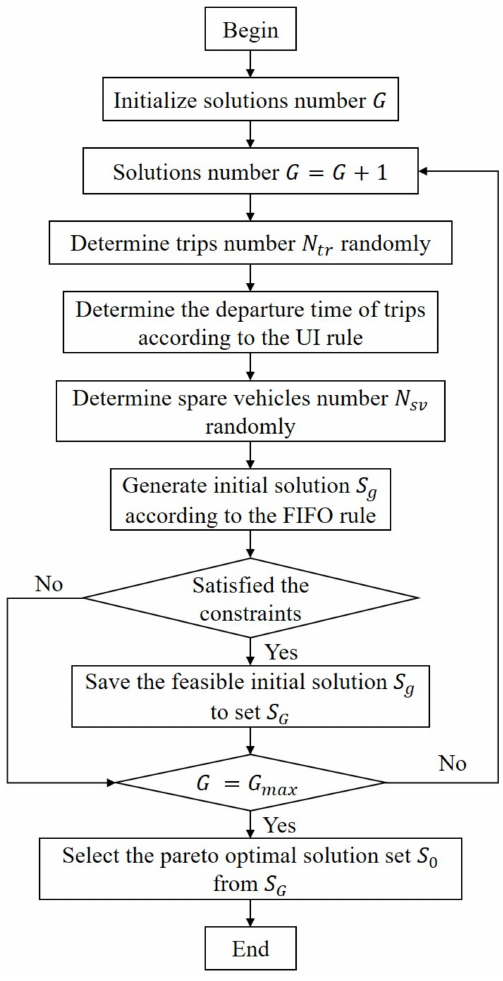
Figure 6. The flowchart of algorithm